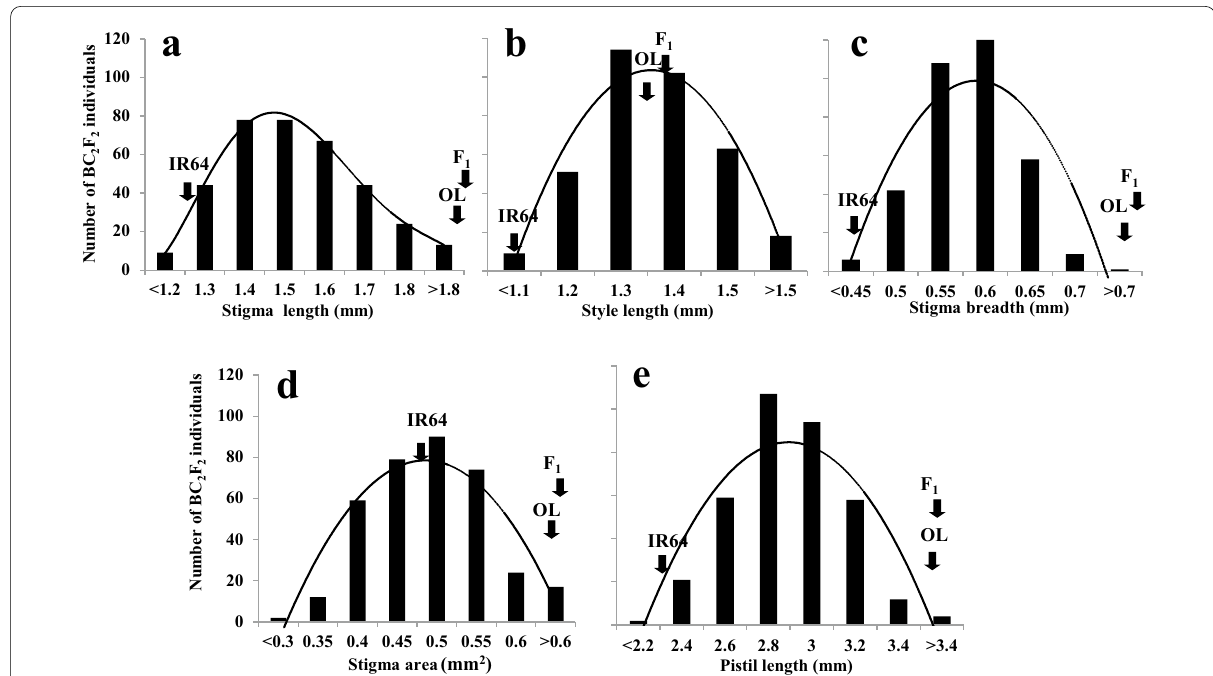
Fig. 1 Frequency distribution of floral traits a stigma length, b style length, c stigma breadth, d stigma area, and pistil length in an IR64 OL(IRGC110404)‑derived BC 2 F 2 mapping population. Arrow indicates the phenotypic value of IR64, F 1 , and OL plants for the respective floral ×